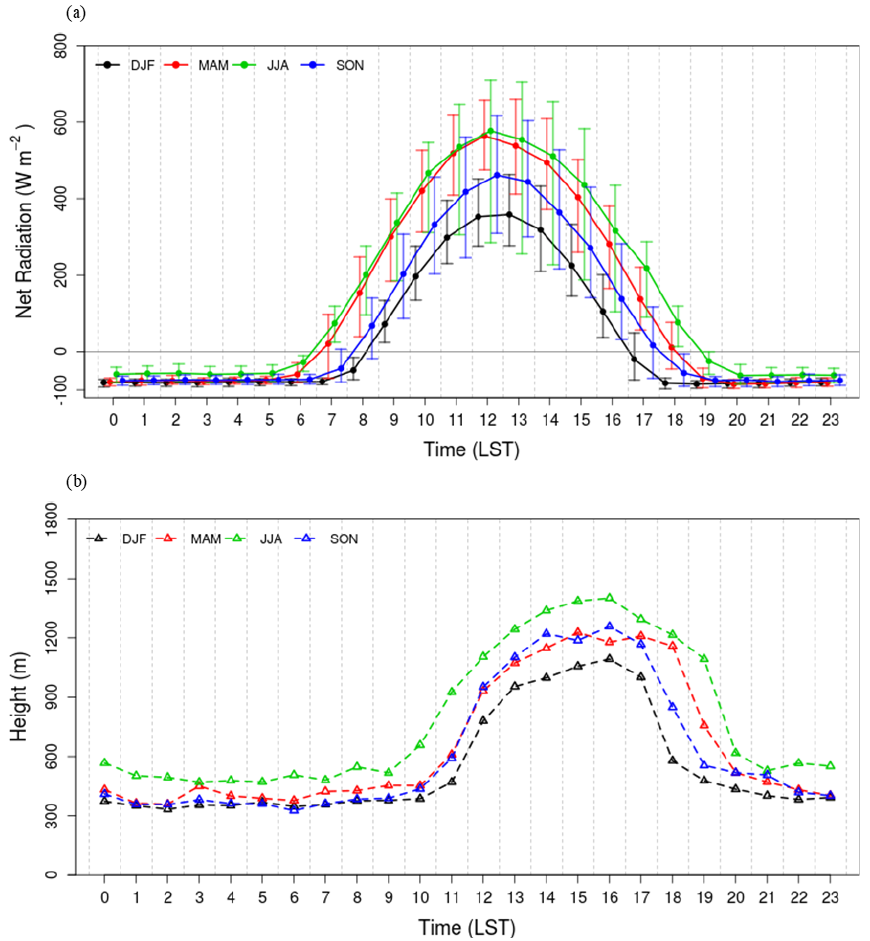
Figure 15. Seasonal mean diurnal variation of (a) net radiation with the 10th and 90th percentiles, and (b) ABLH estimated by